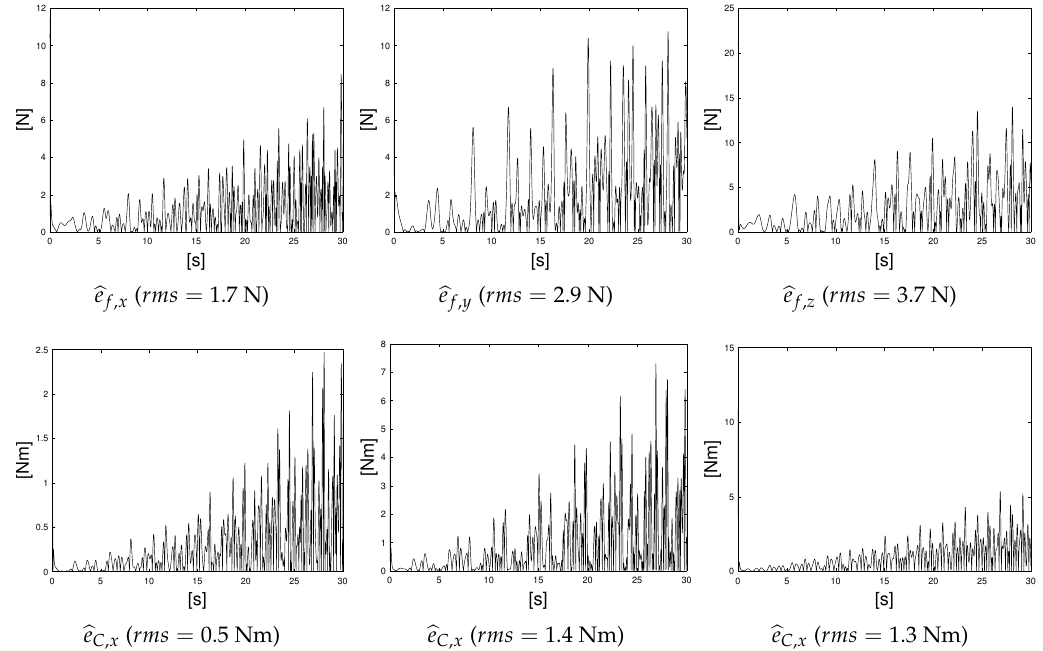
Figure 4. Estimated interaction forces (cid:98) e f and torques (cid:98) e C errors for the #2 simulation